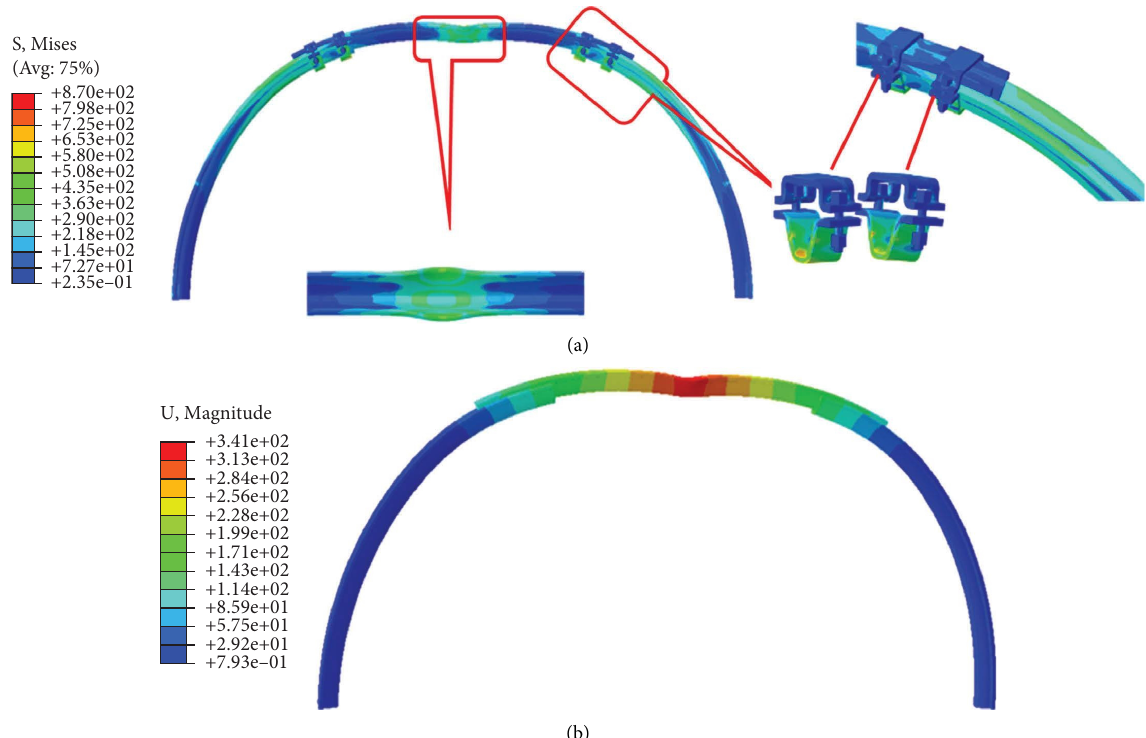
Figure 10: Stress and displacement nephogram of the stent ( t � 0.028s). (a) Support stress and deformation diagram. (b) Support the displacement and deformation diagram.